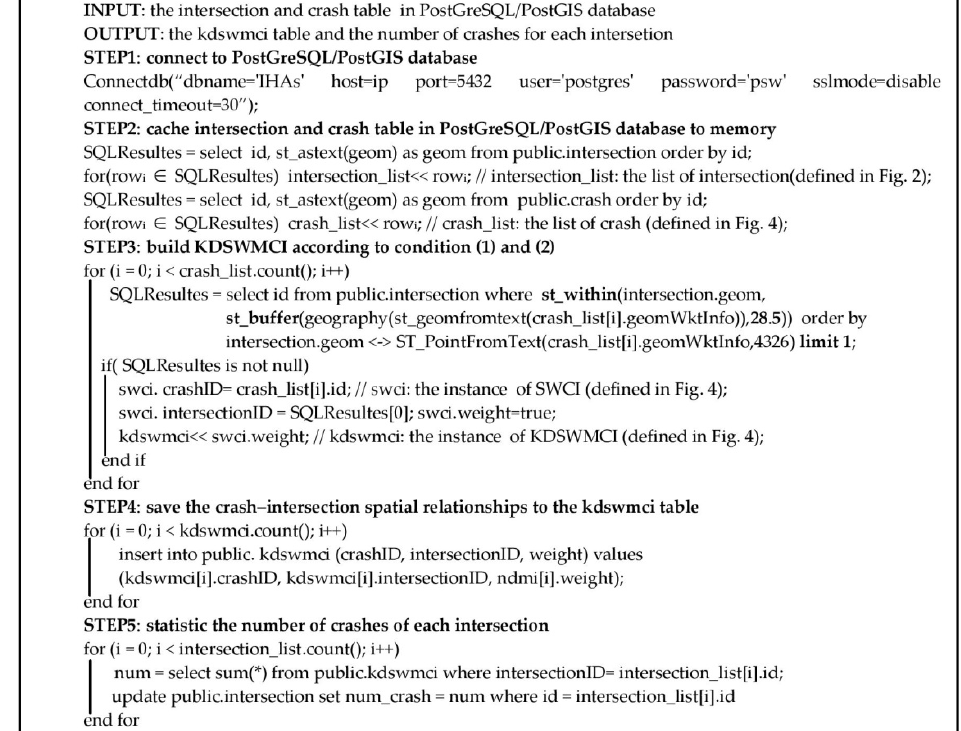
Figure 5. The KDSWMCI generation algorithm.